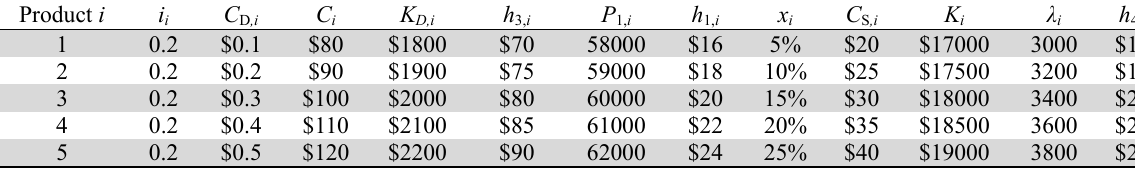
The corresponding variables’ values as in a one-stage fabricating